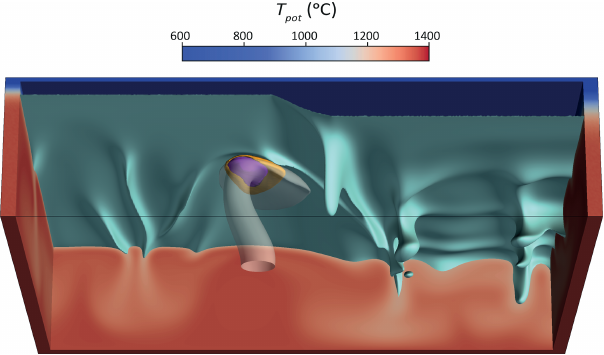
Figure A5. Snapshot of test case with an increased continental lithospheric thickness ( τ c = 200Ma), D plume = 200km, and other properties as in the reference case. See text for